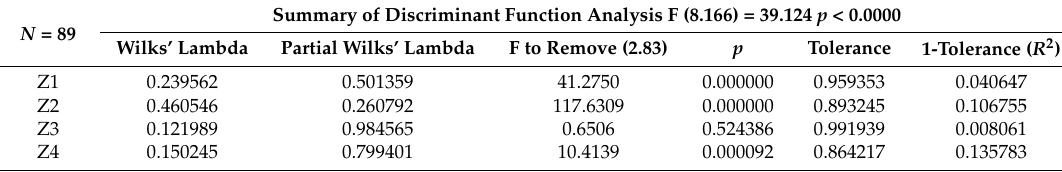
Table 5. Discriminant variables choice results.